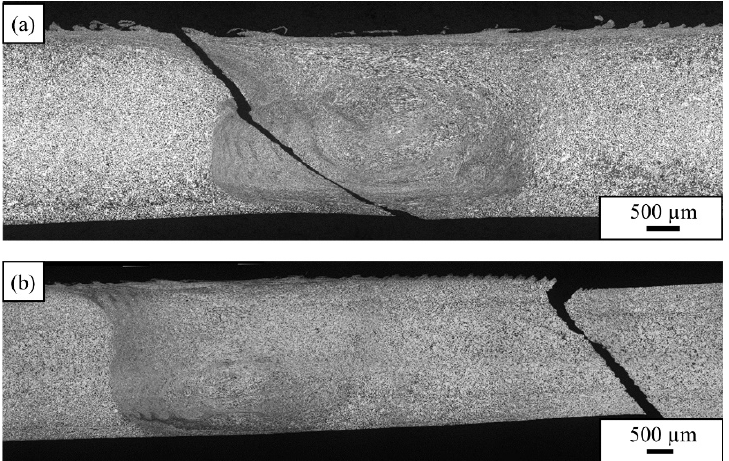
Figure 15. Cross section of fracture surface of tensile-tested specimen of ( a ) AlSi10MnMg; and ( b ) AlMg4Fe2 welds